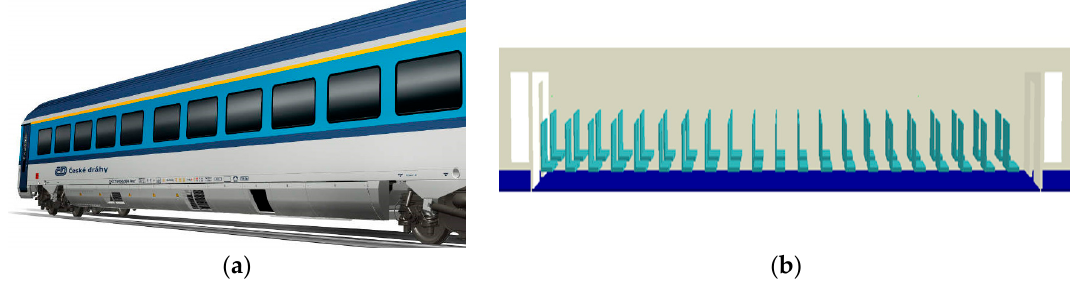
Figure1. ( a )SiemensViaggioComfort[35]. ( b )SideviewofmodelledcarriageasmodelledinSmokeview. Figure 1. ( a ) Siemens Viaggio Comfort [35]. ( b ) Side view of modelled carriage as modelled in Smokeview..